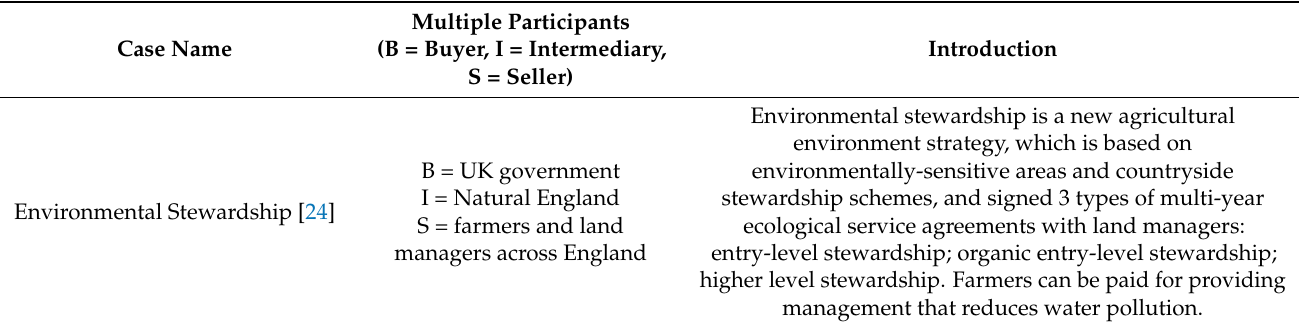
Table 1. The classic cases of payments for ecosystem service in